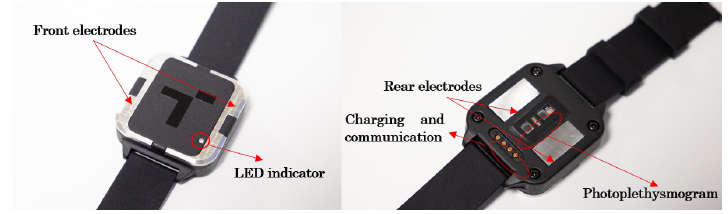
Figure 18. Front and rear side of the